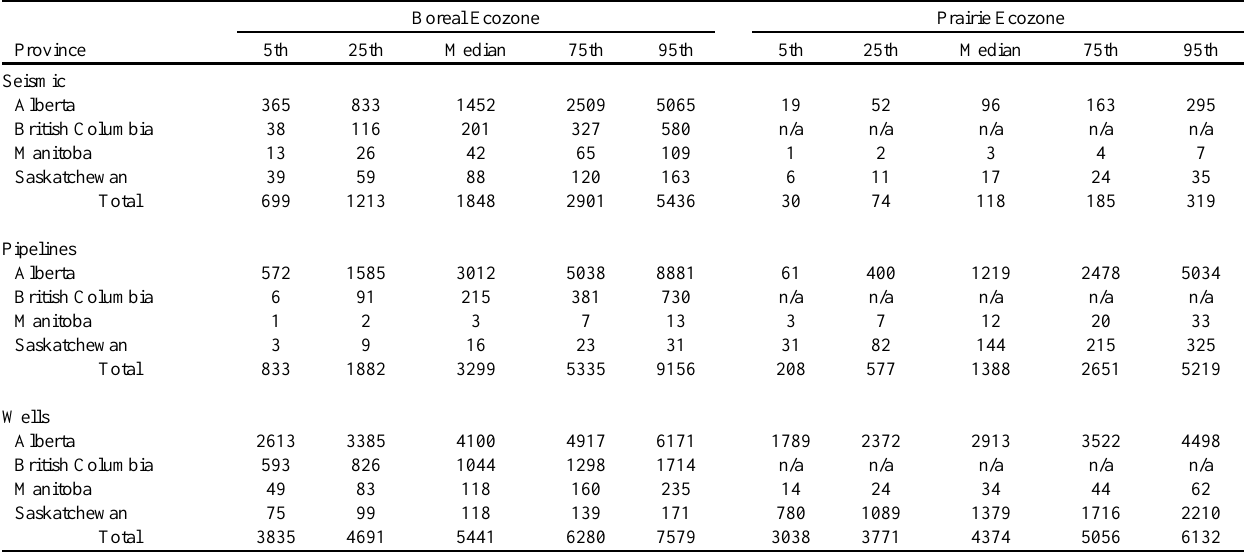
Table 4 . Estimated lost recruitment into year because of pipeline, seismic line, and well site construction during the migratory t+1 bird breeding season for the boreal and prairie ecozones within the Western Canadian Sedimentary Basin. Estimates were derived from Monte Carlo simulations incorporating variance associated with differing assumptions regarding amount and timing of disturbance relative to the breeding season, nest densities, and interannual variation in industrial activity (see Methods). Boreal Ecozone Prairie Ecozone